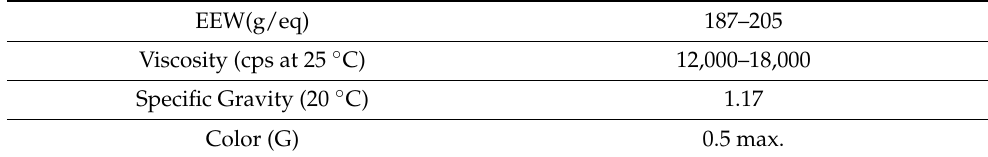
Table 1. Resin Properties